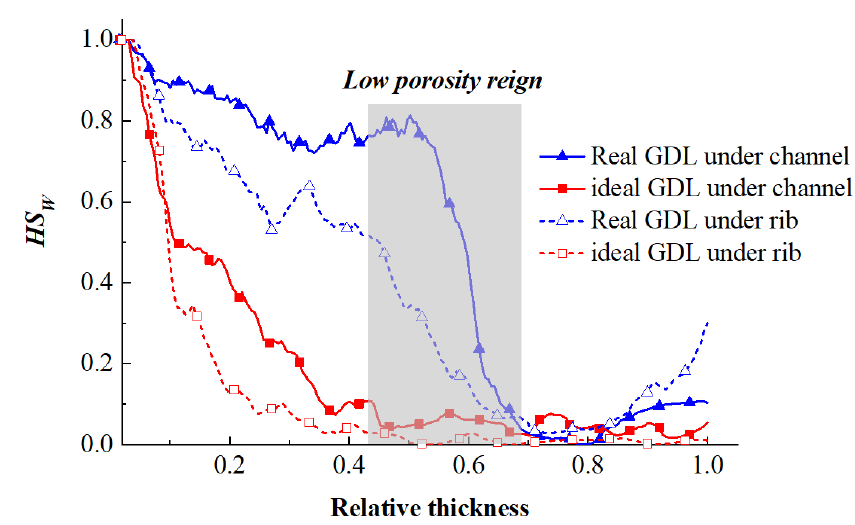
Figure 4. HS w of real GDL and ideal GDL in the thickness direction.